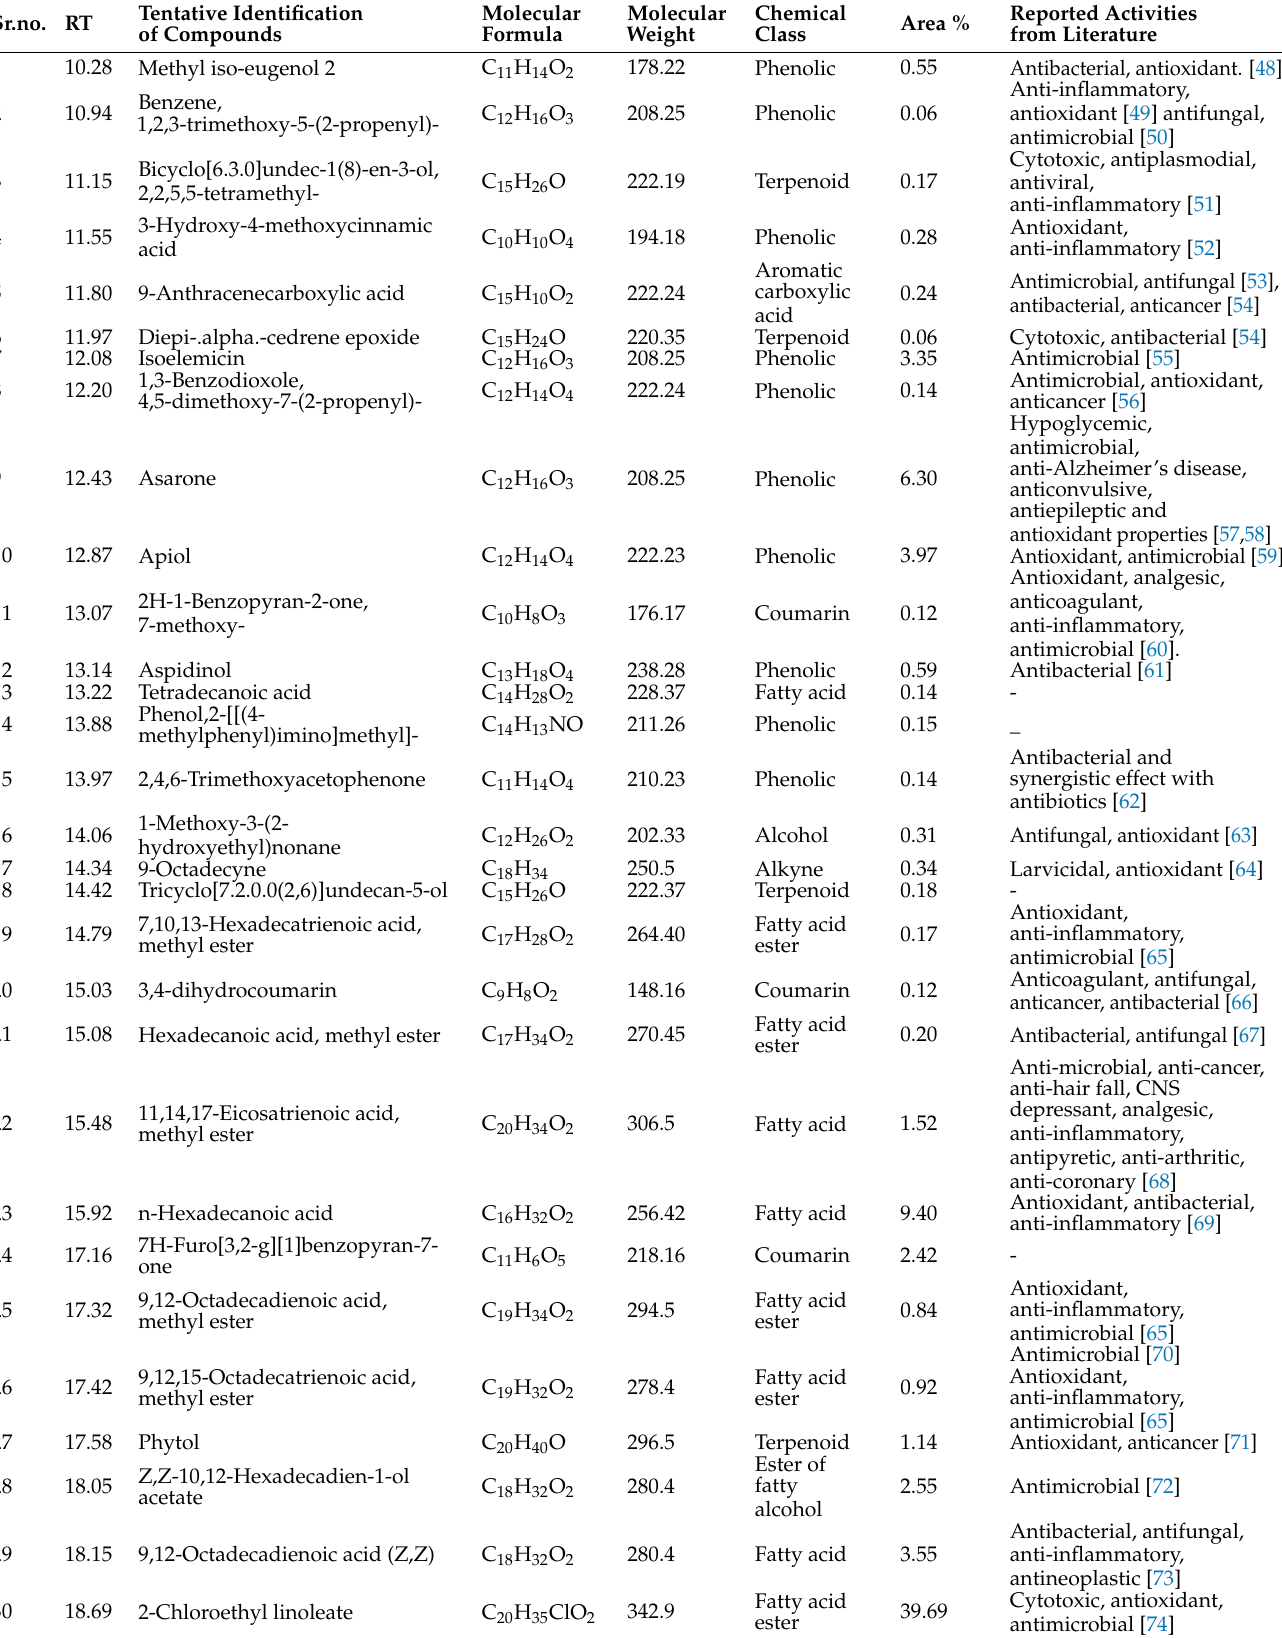
Table 3. Phytochemical profiling of n -hexane (PCHF) fraction of P. candollei through GCMS analysis. Sr.no.